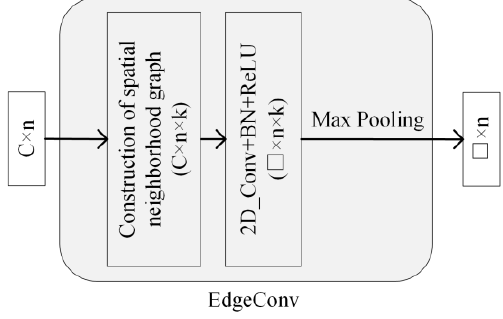
Figure 4. Edge convolution block.